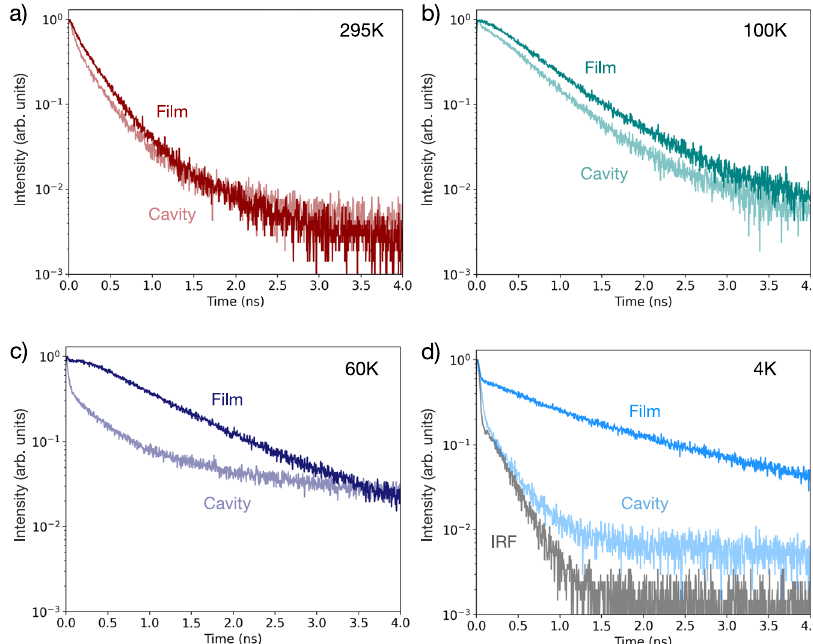
Fig. 4 | Temperature-dependent thin fi lm and strongly coupled microcavity dynamics. a – d The bare 2D perovskite fi lm time-resolved photoluminescence (TRPL) decay (dark traces, Film) compared to the strongly coupled microcavity ( _ Ω Rabi =175meV, Δ =+28meV)lowerpolaritonbranch(LPB)emission(lighttraces, Cavity) as a function of temperature (295K, 100K, 60K, 4K). In the bare fi lm, as temperature decreases, the bright exciton (X) emission lifetime decreases and the dark exciton (DX) emission emerges with an increasingly long lifetime, visible as a